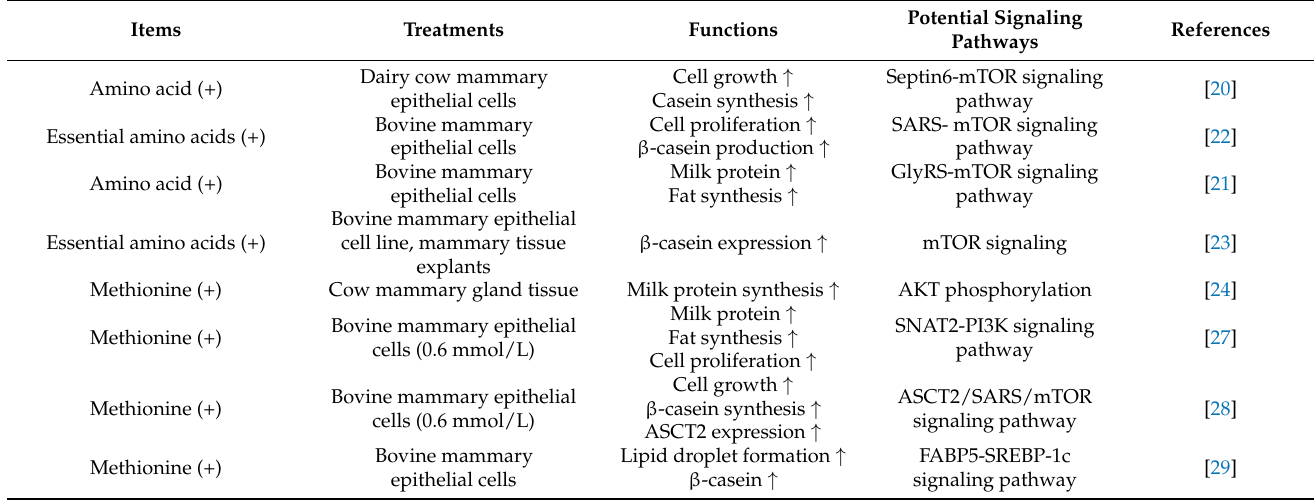
Table 1. Effects of amino acids on milk production and its potential regulatory